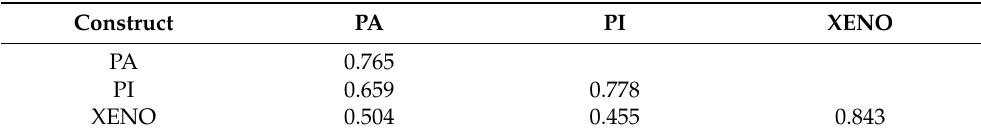
Table 6. Discriminant Validity—Fornell-Larcker